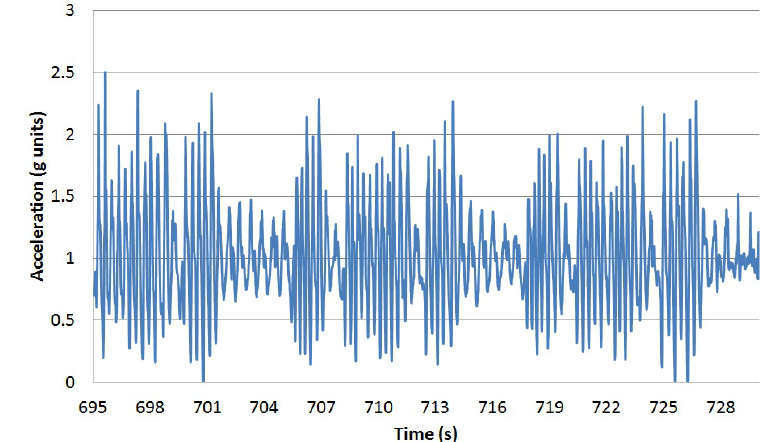
Figure 7. Vertical acceleration over time descending steps for Participant 2.